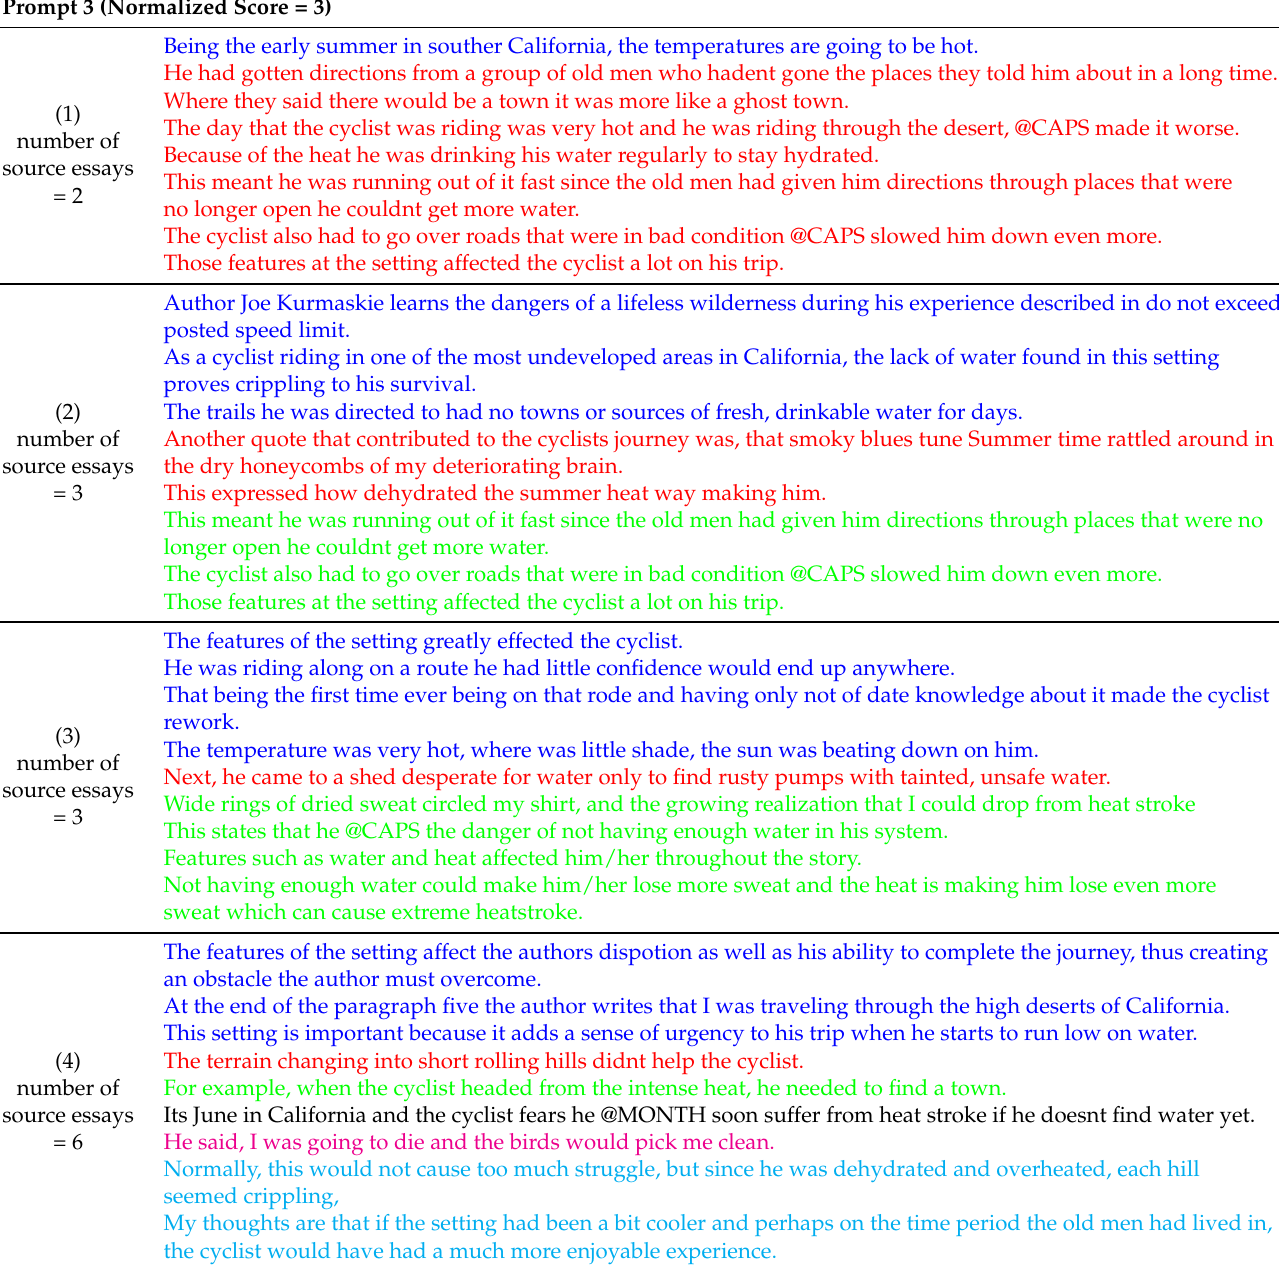
Table A1. Examples of augmented essays corresponding to Prompt 3. (The different colors of the generated essays indicate the different sources of